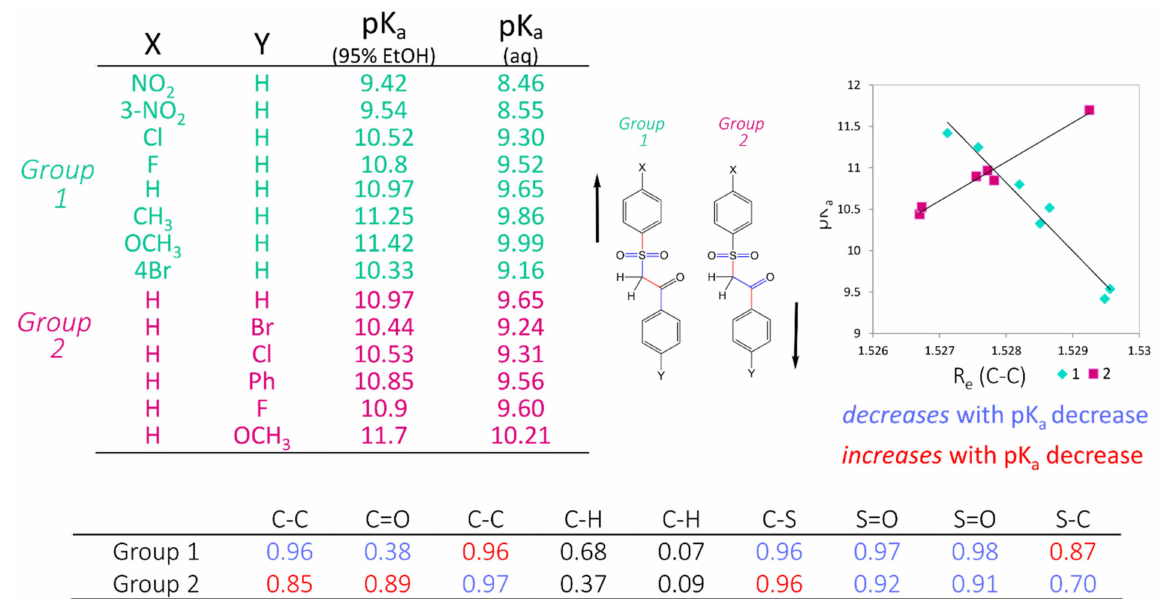
Figure 3. Investigations into the AIBL modelling of sulphone-carbonyl compounds showing the R 2 correlation of the bond length to the pK a .